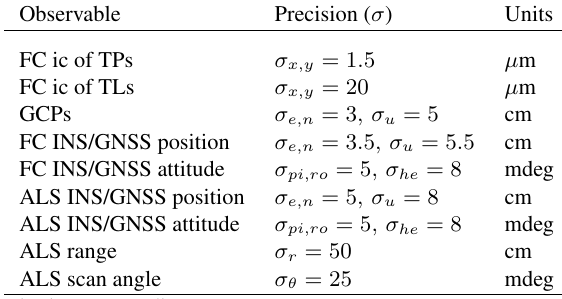
Table 5: Precision of the